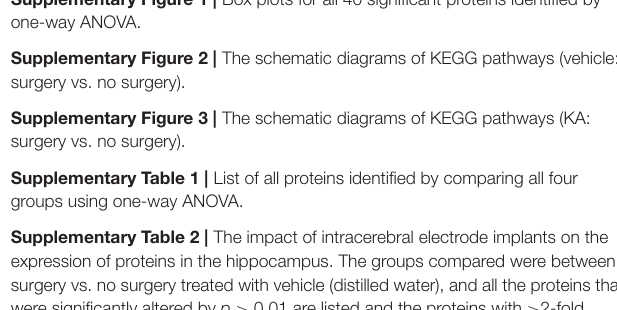
Supplementary Figure 2 | The schematic diagrams of KEGG pathways (vehicle: surgery vs. no surgery). Supplementary Figure 3 | The schematic diagrams of KEGG pathways (KA: surgery vs. no surgery). Supplementary Table 1 | List of all proteins identified by comparing all four groups using one-way ANOVA. Supplementary Table 2 | The impact of intracerebral electrode implants on the expression of proteins in the hippocampus. The groups compared were between surgery vs. no surgery treated with vehicle (distilled water), and all the proteins that were significantly altered by p > 0.01 are listed and the proteins with > 2-fold change are highlighted. Supplementary Table 3 | The impact of KA-induced SE in intracerebral electrode implanted animals on the expression of proteins in the hippocampus. The groups compared were between surgery vs. no surgery treated with KA, and all the proteins that were significantly altered by p > 0.01 are listed and the proteins with > 2-fold change are highlighted. Supplementary Table 4 | The list of KEGG pathways and the key proteins of the pathways affected by intracerebral electrode implants. The groups compared were between surgery vs. no surgery and treated with the vehicle (distilled water). Supplementary Table 5 | The list of KEGG pathways and the key proteins of the pathways affected by intracerebral electrode implants and KA-induced SE. The groups compared were between surgery vs. no surgery and treated with